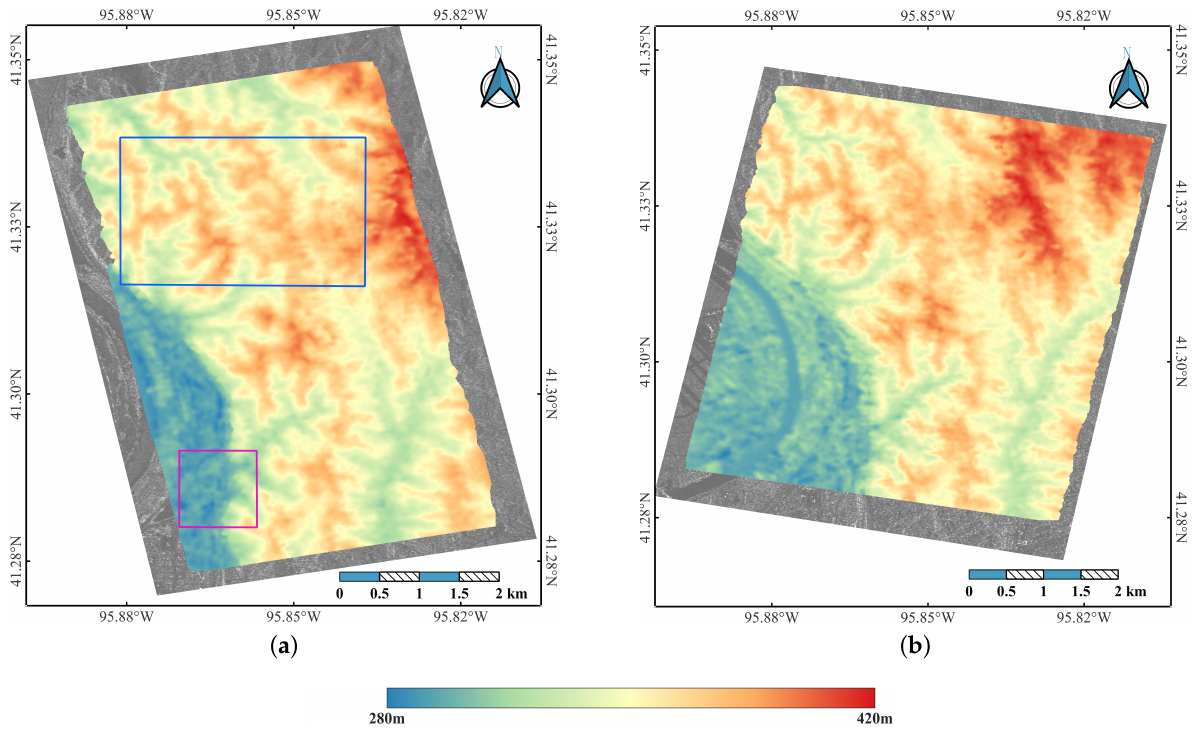
Figure 6. ( a ) The DSM generated by the ascending orbit stereo images. ( b ) The DSM generated by the descending orbit stereo